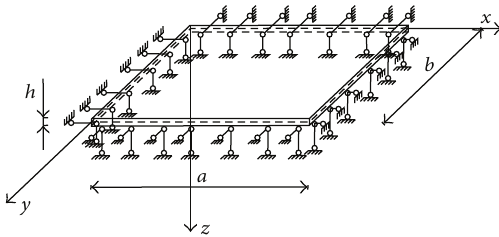
Figure 1: Scheme of a freely supported rectangular plate.